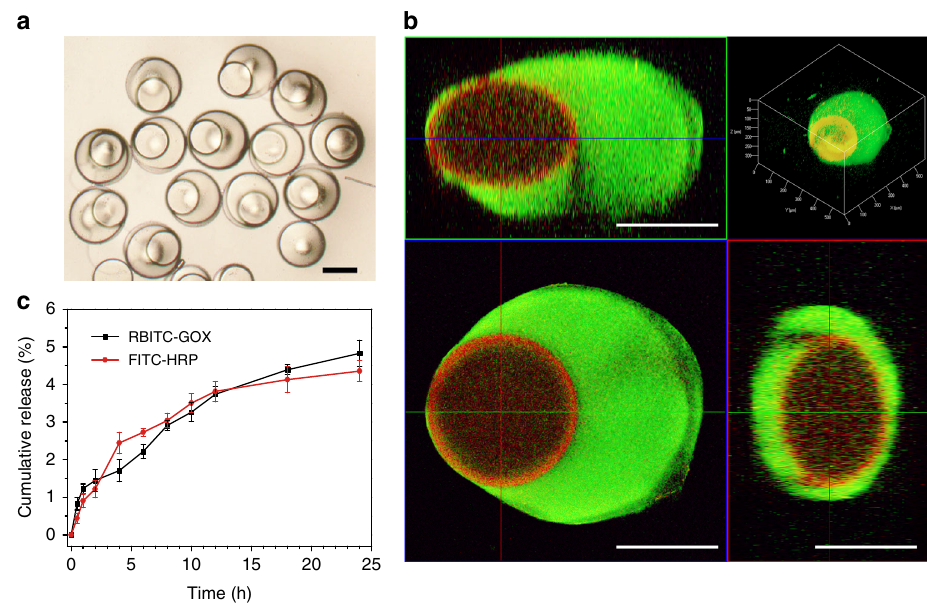
Fig. 2 Encapsulation of GOX and HRP in a multi-compartmental particle. a Bright- fi eld microscopic image of GOX@HRP. b Confocal scanning laser microscopic images of GOX@HRP in x – y , x – z and y – z planes, along with a 3D model of GOX@HRP. The GOX and HRP were labeled with rhodamine B isothiocyanate (RBITC, red ) and fl uorescein isothiocyanate (FITC, green ), respectively. Detailed labeling procedures are discussed in Supplementary Methods (Labeling of enzymes with fl uorescent dyes). c GOX and HRP release pro fi les from GOX@HRP in PBS (10 mM, pH 7.0). Scaling bars are 200 μ